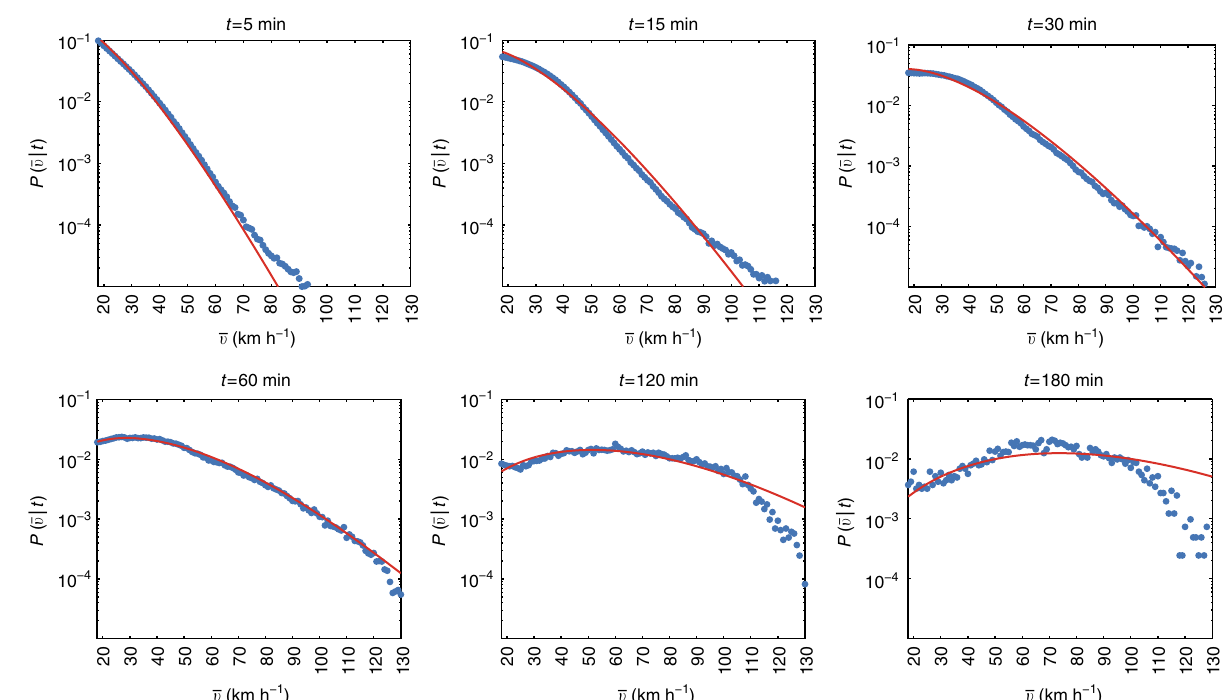
Figure 4 | Conditional distribution P (cid:2) v t jð Þ of the average speeds for different travel times. We fit simultaneously the curves P (cid:2) v t jð Þ given by equation (4) in the interval [ v 0 , v max ], with v 0 ¼ 17.9kmh (cid:2) 1 and v max ¼ 130kmh (cid:2) 1 and for t ¼ 5, 10, 15, 20, y , 180min (see Methods section). Each plot refers to a different trip durations ( t ¼ 5, 15, 30, 60, 120, 180min). The dots are the empirical data whereas the solid line is the fit obtained using equation (4). The best fit value of the parameters are p 0 ¼ 1.06 jumps per hour, d v 0 ¼ 20.9kmh (cid:2) 1 (and v 0 ¼ 17.9kmh (cid:2) 1 ). We therefore get d v E 40kmh (cid:2) 1 for the speed gap, in excellent agreement with the progression of the most common speed limits in Italy: 50kmh (cid:2) 1 (urban), 90kmh (cid:2) 1 (extra-urban) and 130kmh (cid:2) 1 (highways). These results suggest that a multilayer hierarchical transportation infrastructure can explain the constant acceleration observed in both public and private transportation.